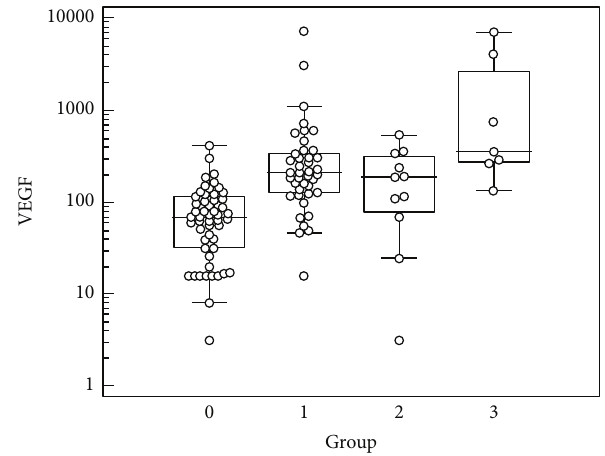
Figure 1: Vascular endothelial growth factor levels for each group. Group 1: proliferative diabetic retinopathy (PDR) patients with no need for repeated surgical intervention; group 2: PDR patients with repeated vitreous bleeding, which is a less serious complication of PDR; group 3: PDR patients with refractory neovascular glaucoma, which is a serious complication of PDR; group 0: control group.